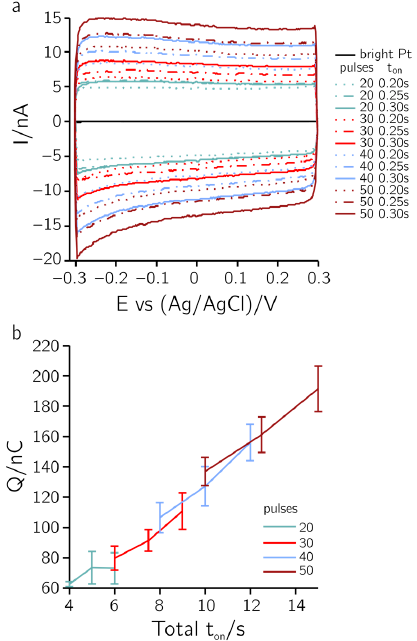
Figure 7. PEDOT. ( a ) CVs in phosphate-buffered saline (PBS) between − 0.3 and 0.3 V vs. Ag/AgCl at 100 mV/s sweep rate, on 25-µm-diameter electrodes. The electrode materials included bright Pt and PEDOT deposited with a t on of 0.2 s, 0.25 s, 0.3 s while applying 20, 30, 40, and 50 pulses. ( b ) Integrated total charge for different total-ton times. Colors code the number of pulses and correspond to (a). The integrated current over a CV of a bright Pt electrode is 200 pC.